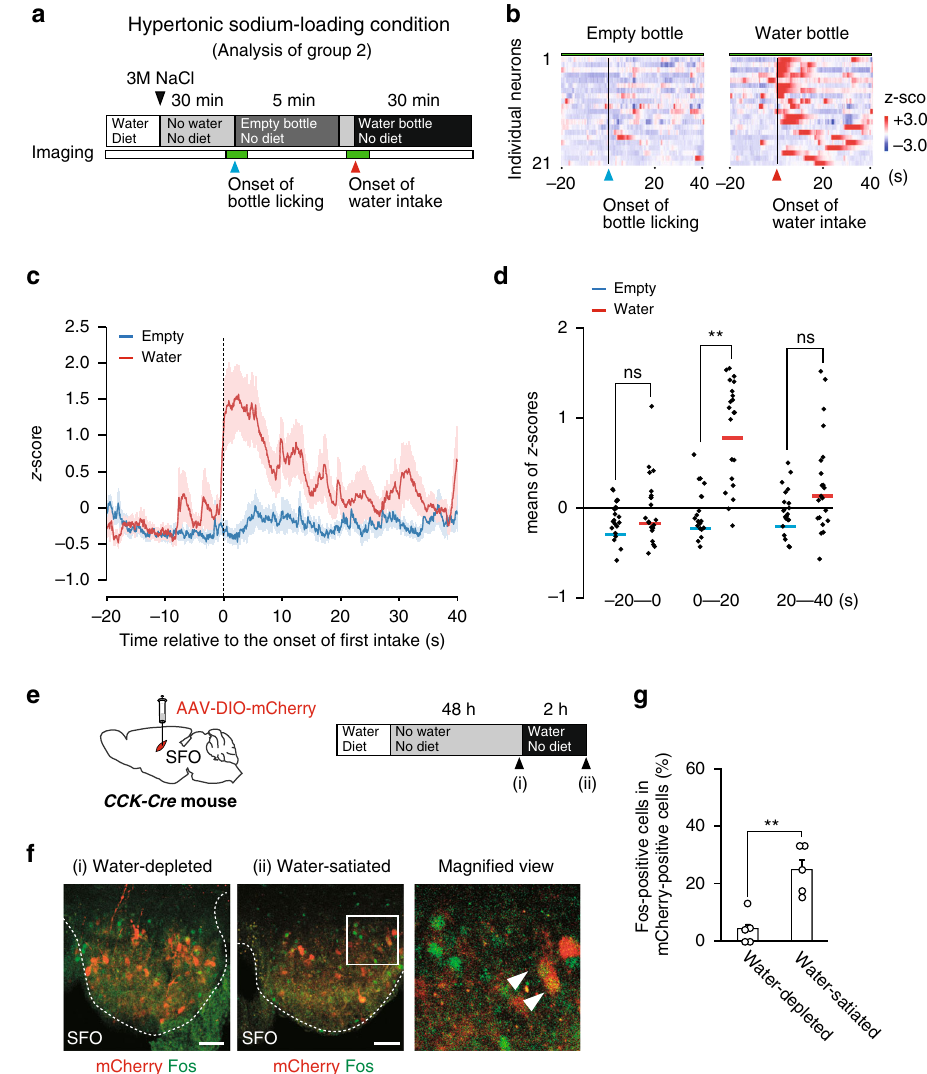
Fig. 6 Group 2 CCK-positive neurons in the SFO are immediately activated in response to water intake. a Experimental protocol for Ca 2 + imaging of group 2 CCK-positive neurons during drinking behaviors. b Raster plots of z -scored calcium responses by individual CCK-positive neurons during licking the empty bottle or drinking water ( n = 21 neurons in two mice). c Averages of z -scored calcium responses during access to the water (or empty) bottle and drinking (licking). Shaded areas in red and blue indicate error bars. d Dot plot of mean z -scores of individual CCK-positive neurons during each 20-s interval at three temporal positions in ( c ). n = 21 neurons in two mice. ns, not signi fi cant. ** P < 0.01; two-sided paired Student ’ s t -tests ( P ( − 20) = 0.333; P (0) = 5.99 × 10 − 6 ; P (20) = 0.053). e Left: Injection of AAV-DIO-mCherry into the SFO of the CCK-Cre mouse. Right: Experimental protocol to con fi rm the activation of group 2 CCK-positive neurons after water intake under the water-depleted condition. f Immunohistochemical detection of mCherry and Fos in the SFO under the water-depleted and water-satiated conditions. Arrowheads in the magni fi ed views indicated double-positive cells. These images were reproduced from more than three independent mice. Scale bar, 50 µ m. g Ratio of Fos-positive cells in mCherry-positive cells in the SFO ( U = 0, P = 0.006; n = 5 sections each). ** P < 0.01; two-sided Mann – Whitney U tests. Data represent the mean ±